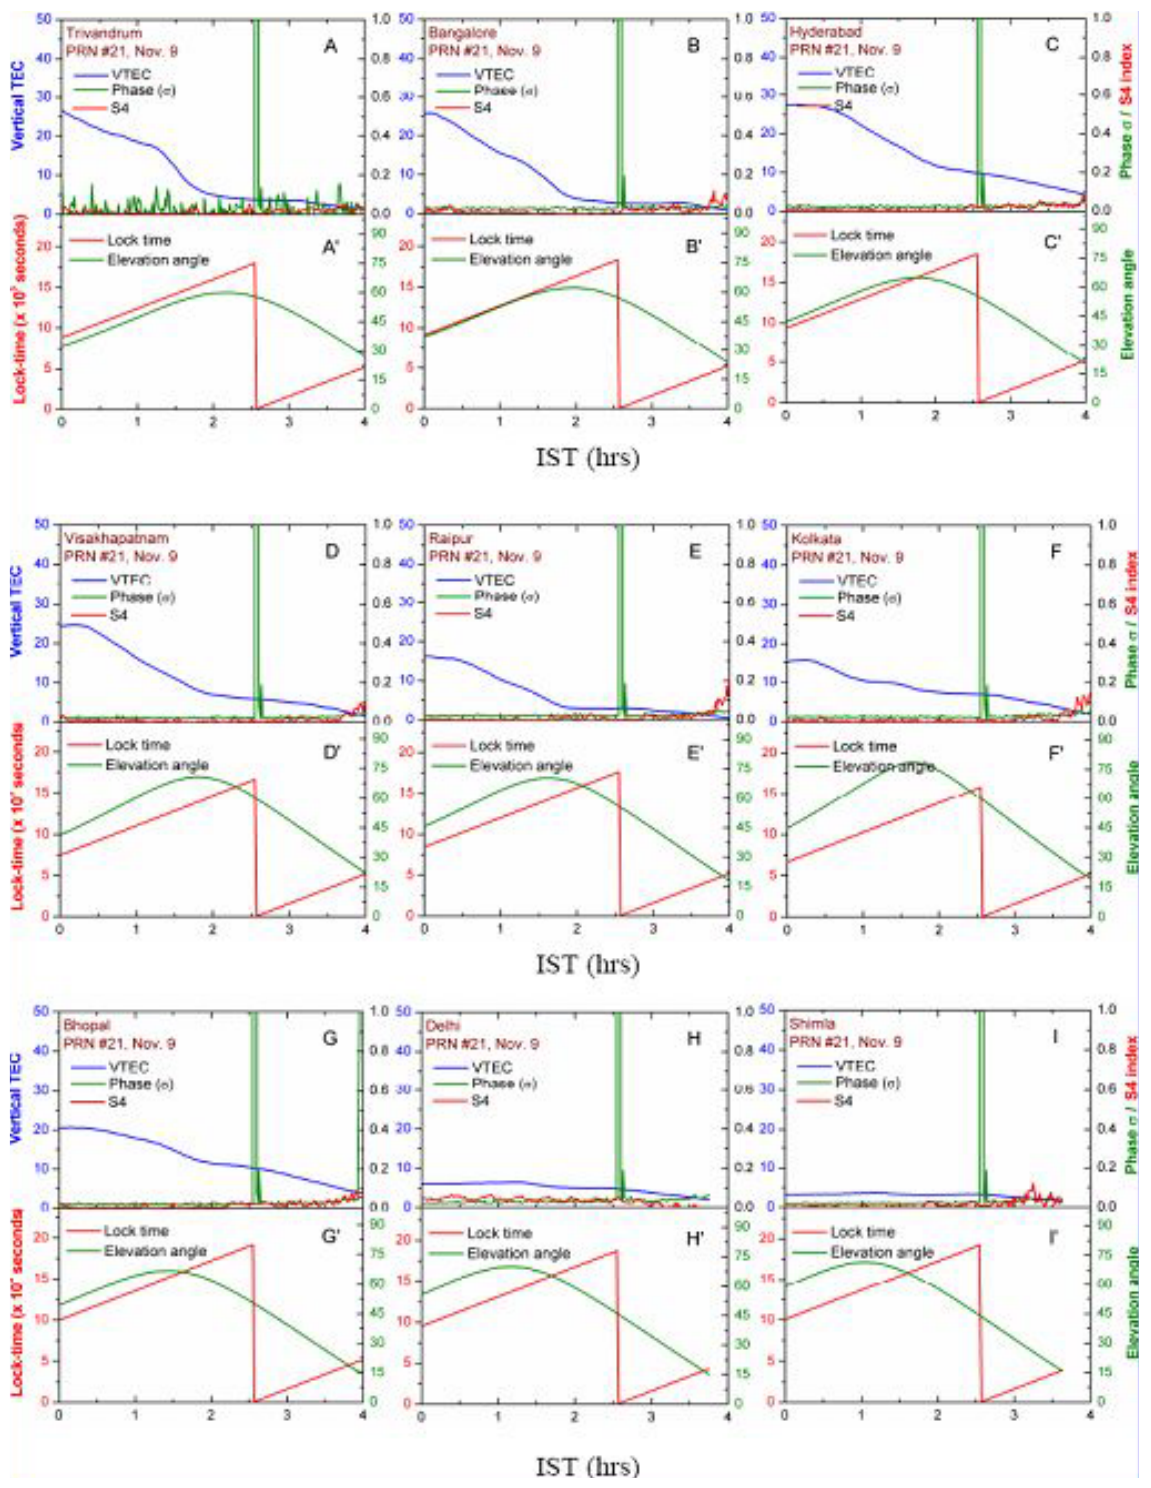
Fig. 6. Phase slips resulting in loss of locks during the storm period of 9 November 2004, presented along with the corresponding S4 index, TEC and lock time of satellite PRN 21 at different